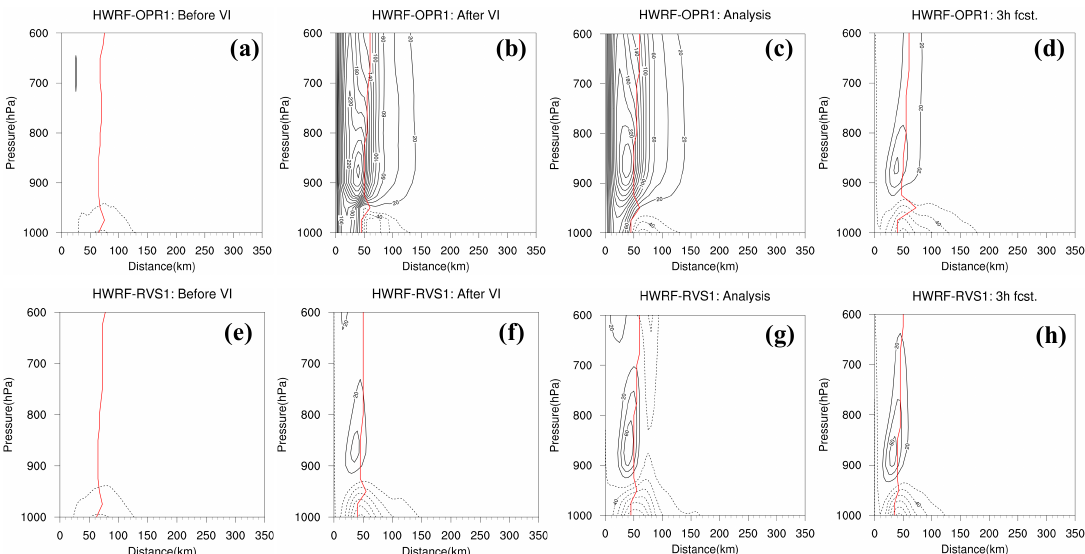
Figure 3. Radius–height cross sections of the isopleths of net radial force per unit mass (unit: m s − 1 h − 1 ). The top four panels show the results from HWRF-OPR1 that are diagnosed ( a ) before vortex initialization (VI), ( b ) after VI, ( c ) after data assimilation (i.e., analysis) and ( d ) 3-h forecast at the analysis cycle of 1800 UTC 03 October 2015. The bottom four panels represent the results from HWRF-REV1 that are diagnosed ( e ) before VI, ( f ) after VI, ( g ) after data assimilation (i.e., analysis) and ( h ) 3-h forecast at the analysis cycle of 1800 UTC 03 October 2015. The contour interval is 20 m s − 1 h − 1 , with dashed lines indicating negative values. The zero contour is not plotted. The red lines indicate the radius of maximum wind. We note that the VI in HWRF-OPR1 enables both the vortex relocation and intensity correction, while VI in HWRF-REV1 only enables the vortex relocation, as shown in Table